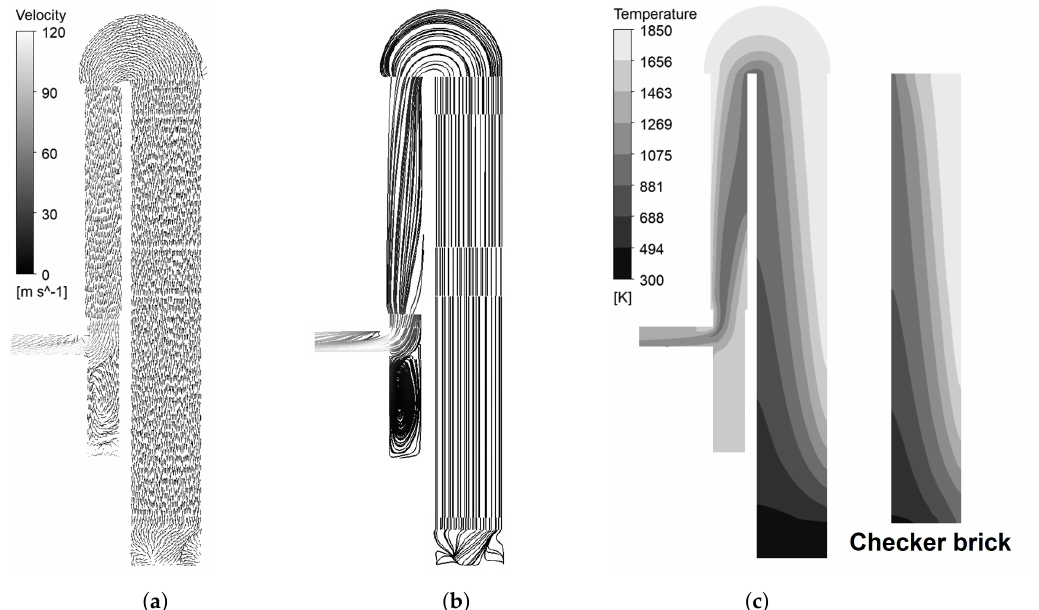
Figure 9. ( a ) The fluid velocity with ( b ) streamline and ( c ) temperature profile in the middle of the on-blast period ( t = 130